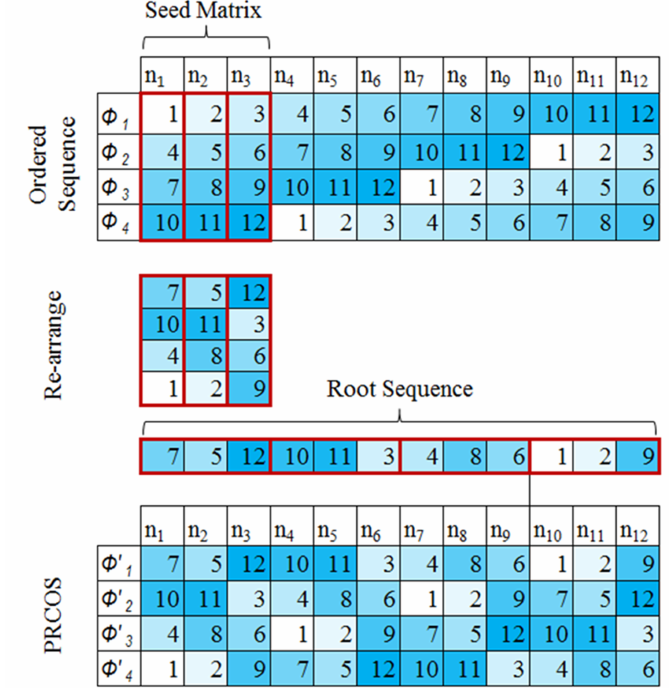
Figure 4. A short sequence example of the proposed generating algorithm with N = 12, g = 3 and M =